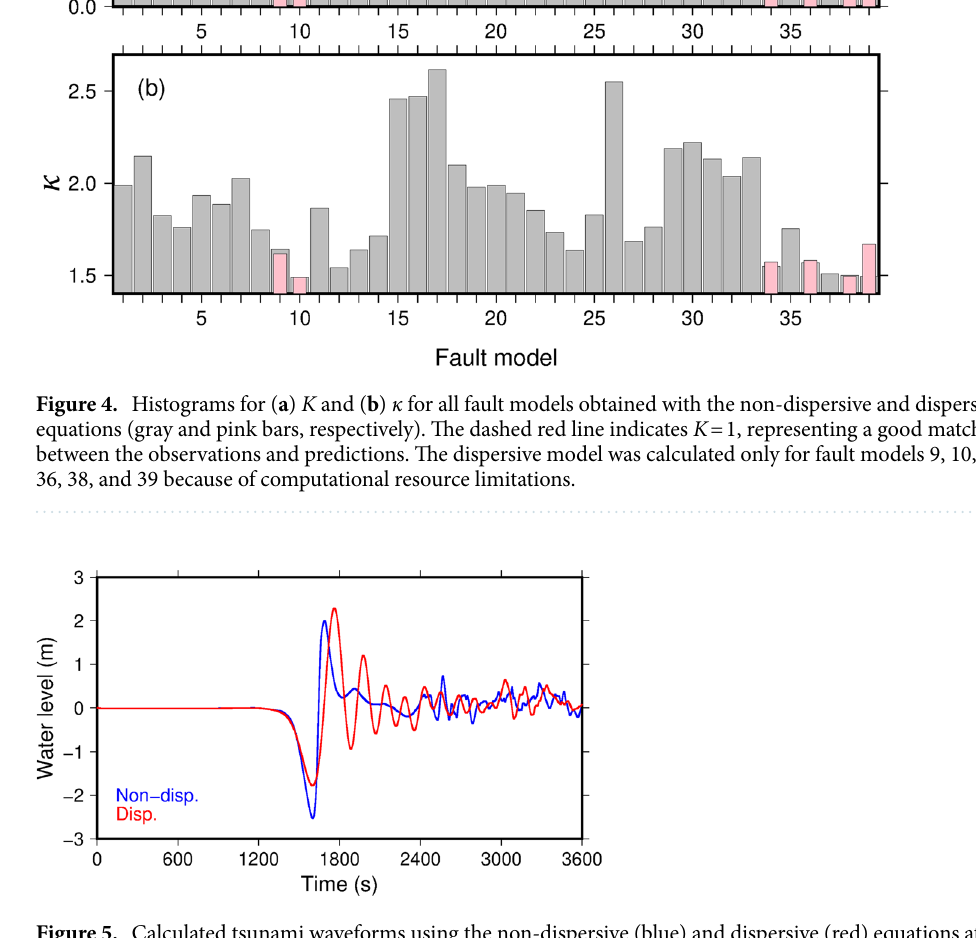
Figure 5. Calculated tsunami waveforms using the non-dispersive (blue) and dispersive (red) equations at a point 20 km offshore and in 200 m water depth (red circle in Fig.